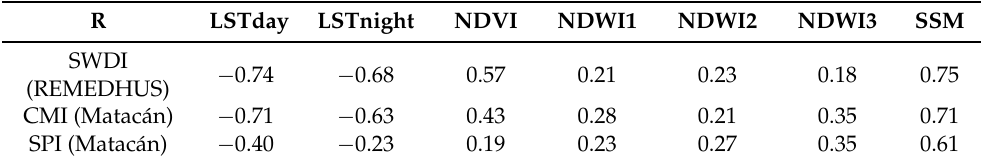
Table 2. Comparison (Pearson coefficient) between SWDI and the SMADI input parameters (LST, NDVI, NDWI and SSM) at the REMEDHUS area average and at the Matacán station. All the correlations have a p -value < 0.01.